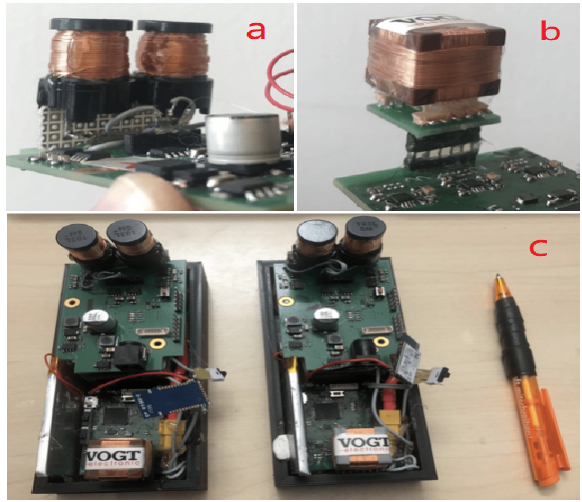
Figure 5. Transmitter coil ( a ), Receiver coil ( b ), and two prototypes ( c